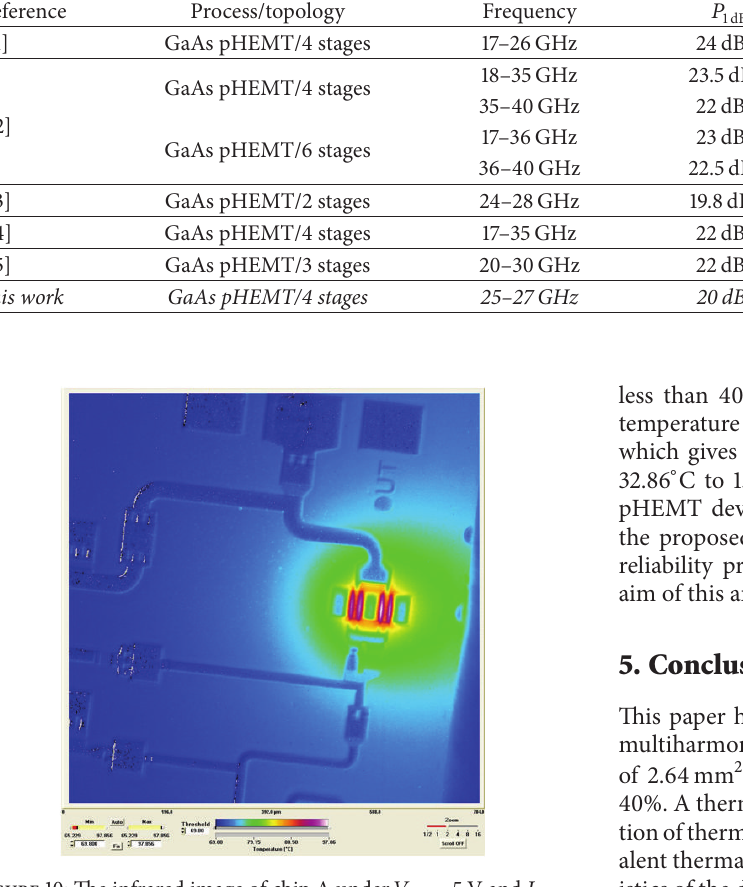
Figure 10: The infrared image of chip A under 𝑉 DS = 5 V and 𝐼 DS = 60 mA.